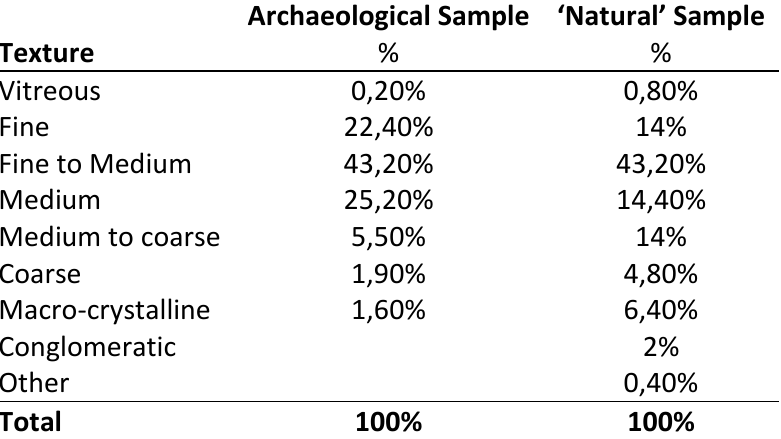
Table 6. Distribution of the observed textures in the archaeological sample in comparison with the ‘natural’